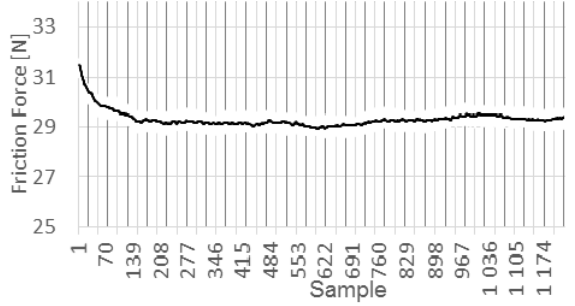
Fig. 5. Friction measurement cycle for the 2 mm/s speed .